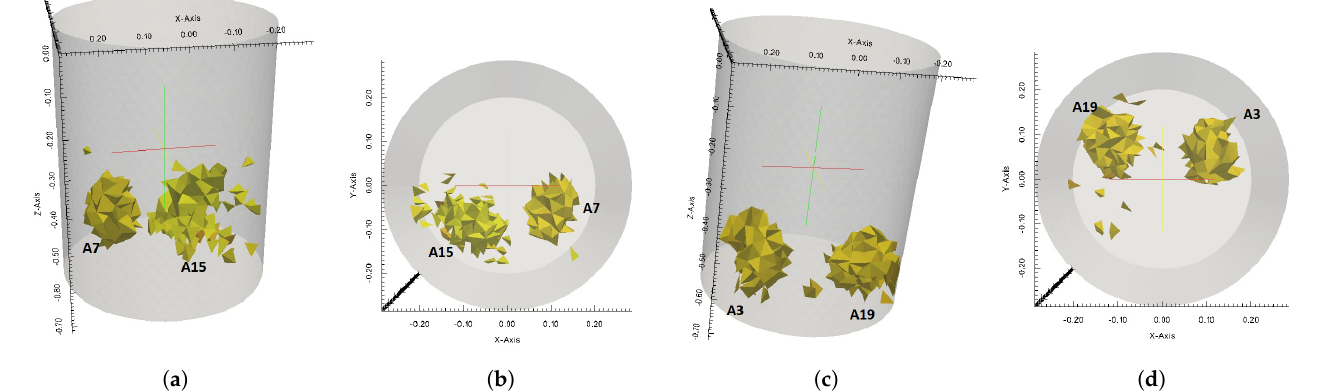
Figure 12. Target tracking at 260 MHz with FLAs, where A# represents the target’s location close to those antennas in the 3rd layer. In each image, we have superimposed two target positions to save space (i.e., each target position represents a separate experiment with a single wet-grain region present). ( a , c ) shows a perspective view of the target and ( b , d ) shows the top view of the target’s position according to its distance to the closest antenna in the 3rd layer. Threshold criteria have been chosen 90% of maximum scaled relative permittivity, i.e.,